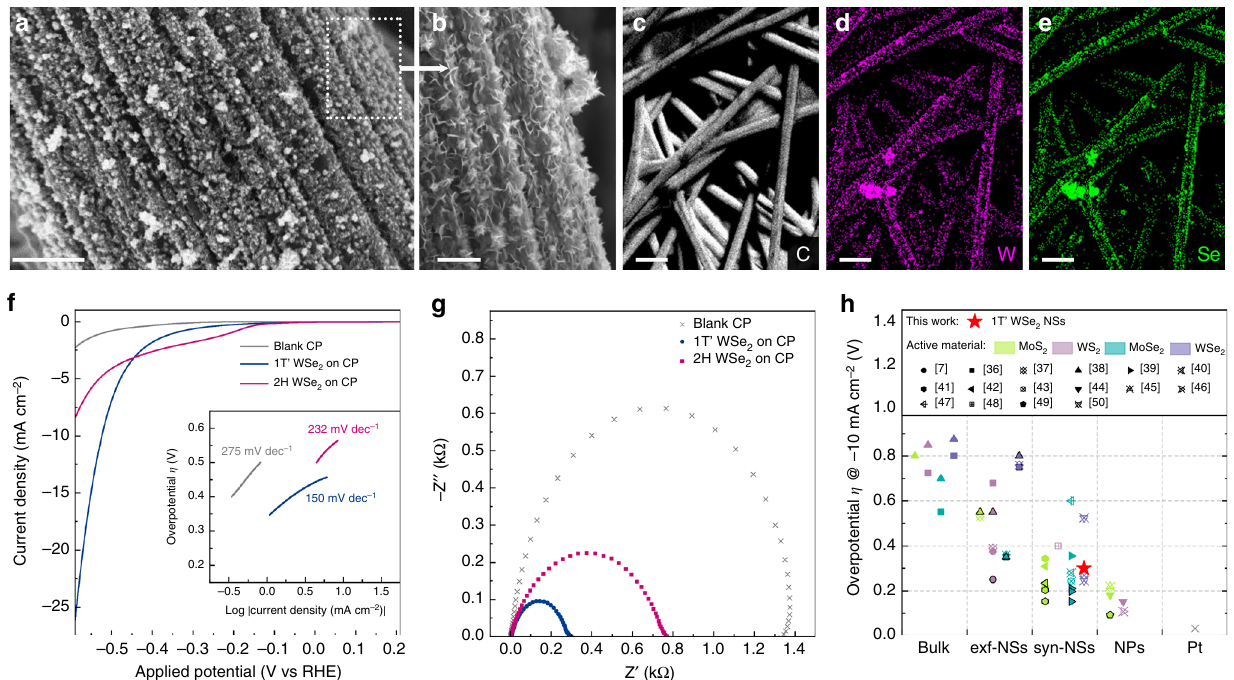
Fig. 4 Electrocatalytic performance of the 1T ’ and 2H WSe 2 nanosheets assembled on carbon paper (CP). a , b Scanning electron microscopic images of the vertically aligned 1T ’ WSe 2 nanosheets densely covering the available surface of carbon fi bres ( a , scale bar: 1 µ m), while maintaining the ultra-thin morphology of the individual petals ( b , scale bar: 500 nm). c – e Elemental (C, W and Se) maps of the WSe 2 nanosheets grown directly on CP illustrating the achieved uniform coverage of the functional substrate (scale bars: 20 µ m). f Polarisation curves of the 1T ’ and 2H WSe 2 nanosheets grown on CP, inset shows corresponding Tafel slopes. g Nyquist plots of the 1T ’ and 2H WSe 2 electrodes. h Comparison with the reported group VI TMD electrocatalysts; comparative data points are taken from refs. 7,43,39,38,44,41,45,46,42,47,37,48,49,40,50,51 and divided into four categories based on the catalyst morphology: bulk material, mechanically and chemically exfoliated nanosheets (exf-NSs), nanosheets produced via wet-chemical approaches (syn-NSs), nanoparticles and clusters (NPs); data points with black borders correspond to the metallic 1T/1T ’ phase of group VI TMDs. Comparison plot with catalyst mass loading stated for each reference data point and 1T ’ and 2H WSe 2 nano fl owers reported in this work is presented in Supplementary Fig.